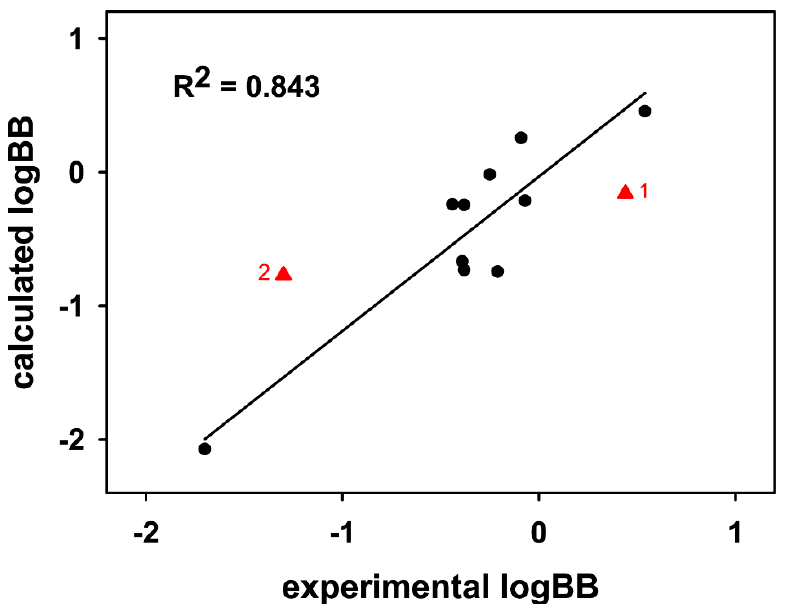
Figure 7. Linear diagram showing correlation between the experimental and calculated LogBB values of the ten drug candidate molecules in comparison with 1 and 2 .